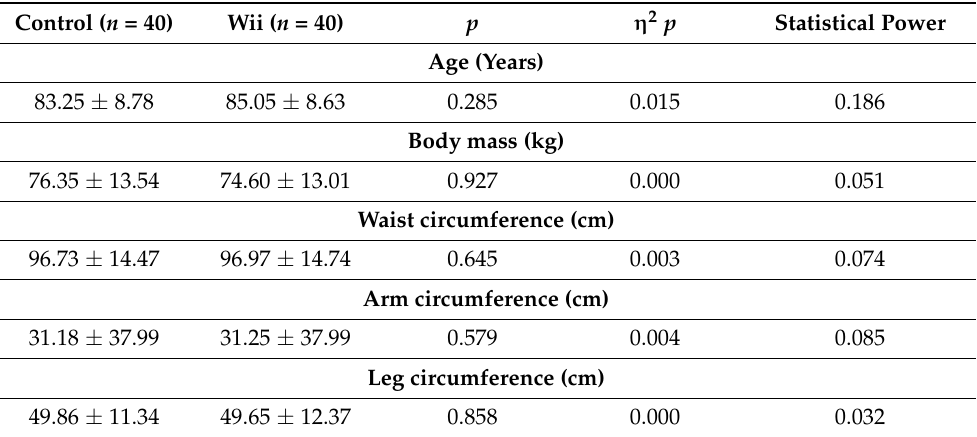
Table 1. Sociodemographic characteristics of the sample at baseline.